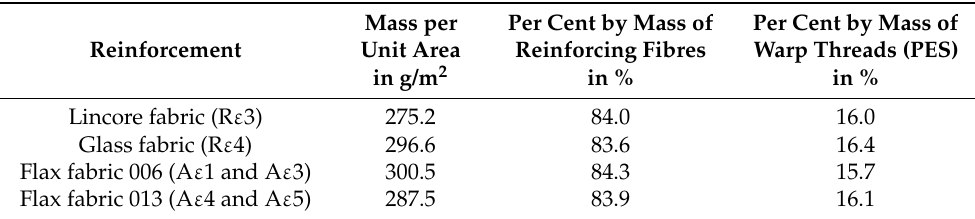
Table 1. Mass per unit area and composition of the fabrics (designations in brackets with Greek letters indicate internal labels which are used for the classification of the samples in the project). Per Cent by Mass of Per Cent by Mass of Mass per Warp Threads (PES) Reinforcing Fibres Reinforcement Unit Area in % in % in g/m 2 Lincore fabric (R ε 3) 275.2 84.0 16.0 Glass fabric (R ε 4) 296.6